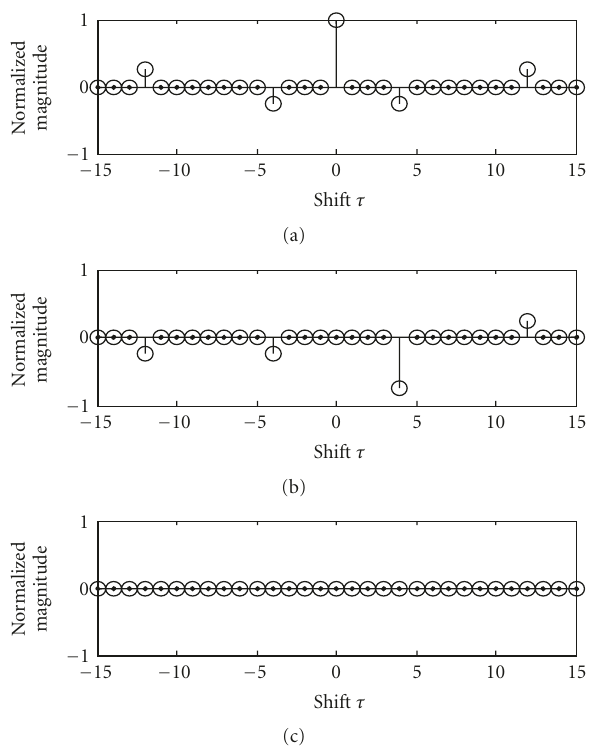
Figure 2: The distribution of aperiodic ACF and CCF val- ues of Z-complementary set Z - CS (8,2,16,2,4). (a) ACF of Z- complementary sequence Δ (1) 1,3 ; (b) intragroup CCF of Δ (1) 1,3 and Δ (1) 1,4 ; (c) intergroup